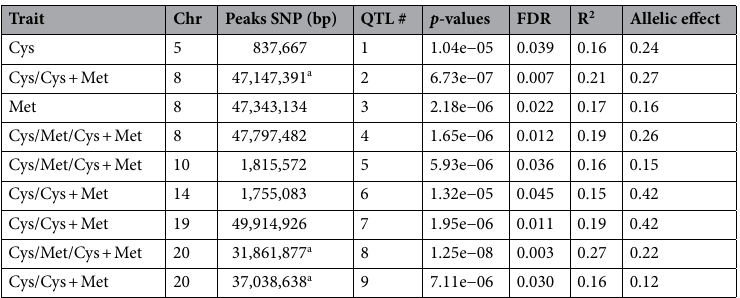
Table 2. The most highly associated SNP markers within each QTL from MLM analyses and their effects on phenotypic variation for sulfur amino acid content in a Canadian soybean collection. a QTLs codetected by MLM and the multi-locus methods.